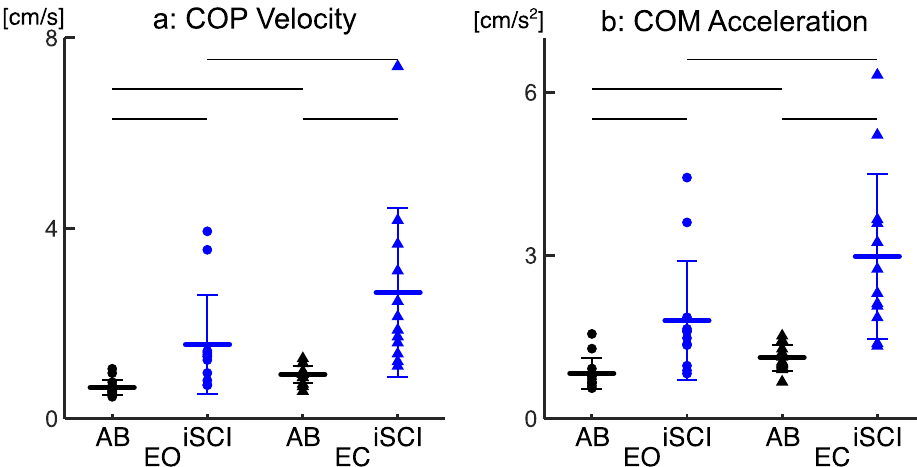
Figure 3. Comparison of the postural sway (standard deviation of the COPv and COMa) during quiet standing between the AB- and iSCI-group. ( a ) Distribution of the COPv fluctuations in the AP direction for EO and EC conditions. ( b ) Distribution of the COMa in the AP direction for EO and EC conditions. Thick blue and black horizontal lines represent the group mean. Thin vertical lines represent the standard deviation of about the mean. Thin black horizontal bar indicates a p-value < 0.05 between the two groups under each condition (AB-group: N = 13—black, iSCI-group: N = 12—blue). Circles are EO condition, EC conditions are